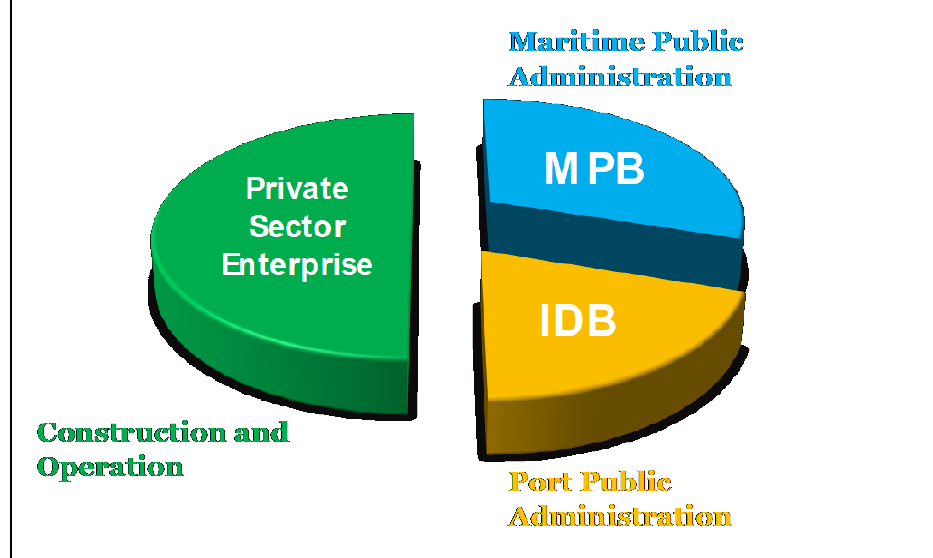
Figure 5. Division of authority and responsibility of exclusive industrial harbors.